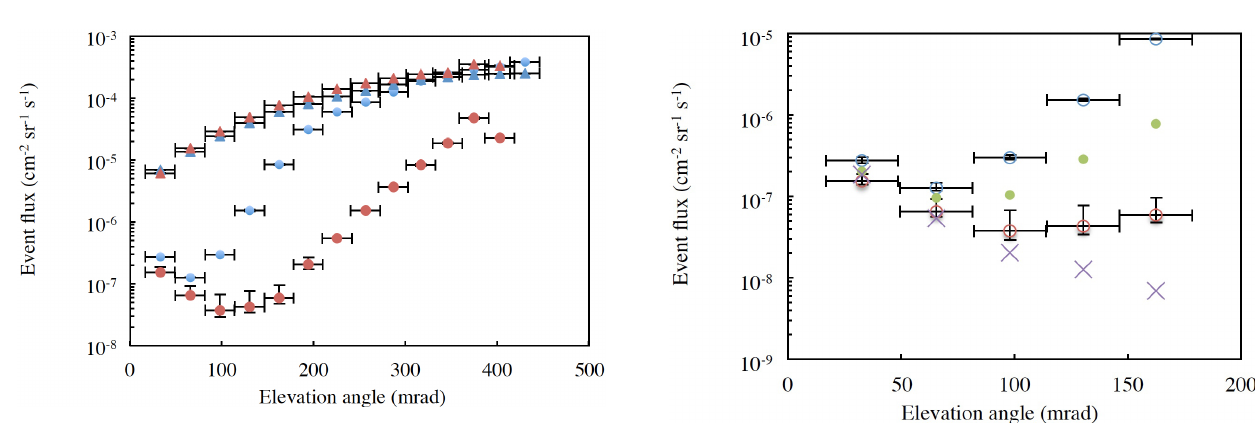
Figure 15. Comparison of the measured and theoretical background fluxes. The blue and red circles show the elevation angle depen- dence on the Shinmoe-dake and Iwo Jima fluxes, and the pur- ple crosses and green circles show the estimated background from backward-directed muons and both forward and backward-directed muons, respectively.